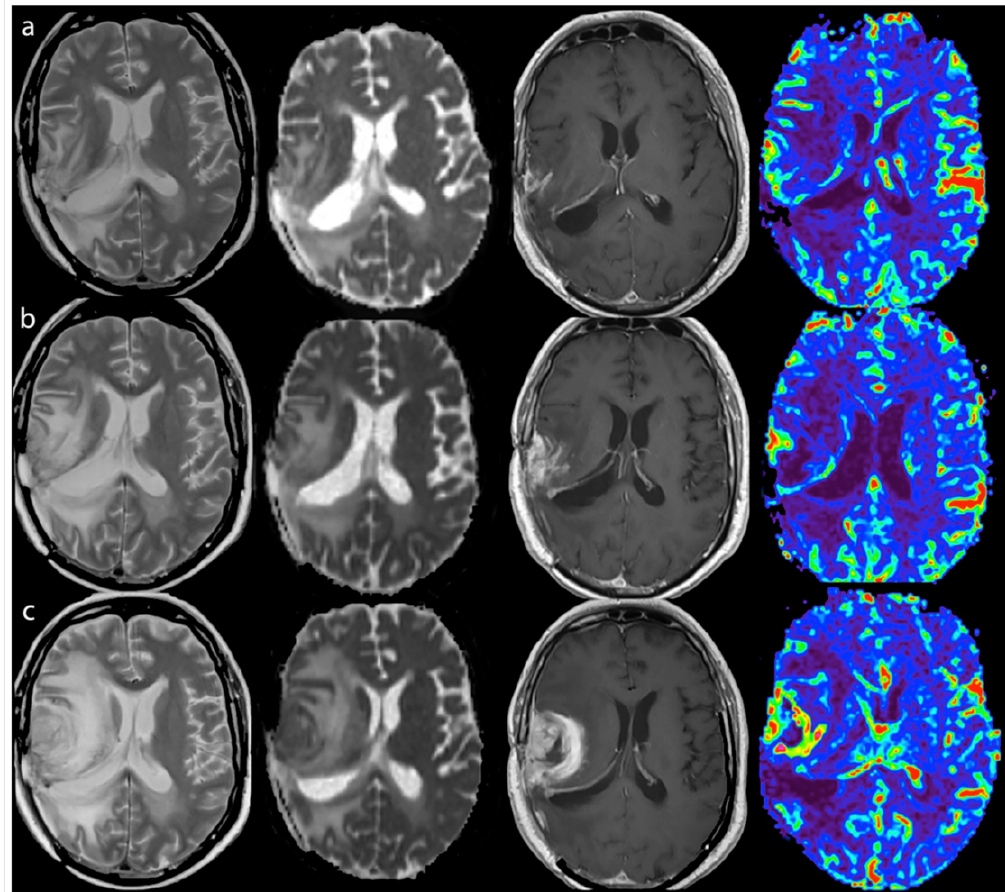
Figure 2. True tumor progression during immunotherapy of a LowNK and Unmethylated MGMT patient - Left to right: T2, ADC map, T1-enhanced and CBV map. ( a ) Oct 2013 after surgery and radio-chemotherapy and first four vaccinations, MRI-2 mo (Steroid dose 3 mg Dexamethazone, clinical condition stable): small GBM residual showing contrast enhancement (T1) and a spot of hyper-perfusion with high CBV (red to green), moderate edema and post-actinic alteration (T2 hyper-intensity) and slight ADC restriction; ( b ) Jan 2014, MRI-6 mo during immunotherapy (Steroid dose 3 mg Dexamethazone, clinical condition stable): enlargement of enhancing, of hyper-perfused and of ADC restricted volumes and of edema; ( c ) Mar 2014, MRI-8 mo after immunotherapy (Steroid dose 8 mg Dexamethazone,